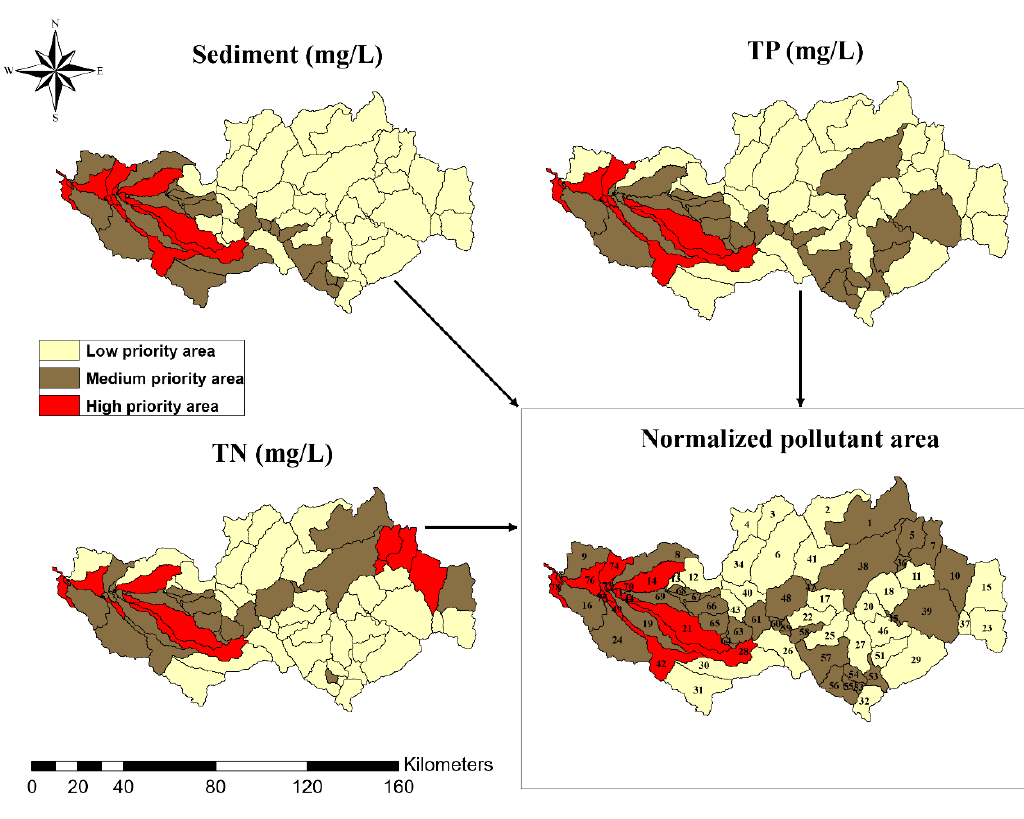
Figure 4. The identified critical hot spots (CHSs) using the CII method. Water 2020 , 12 , x FOR PEER REVIEW